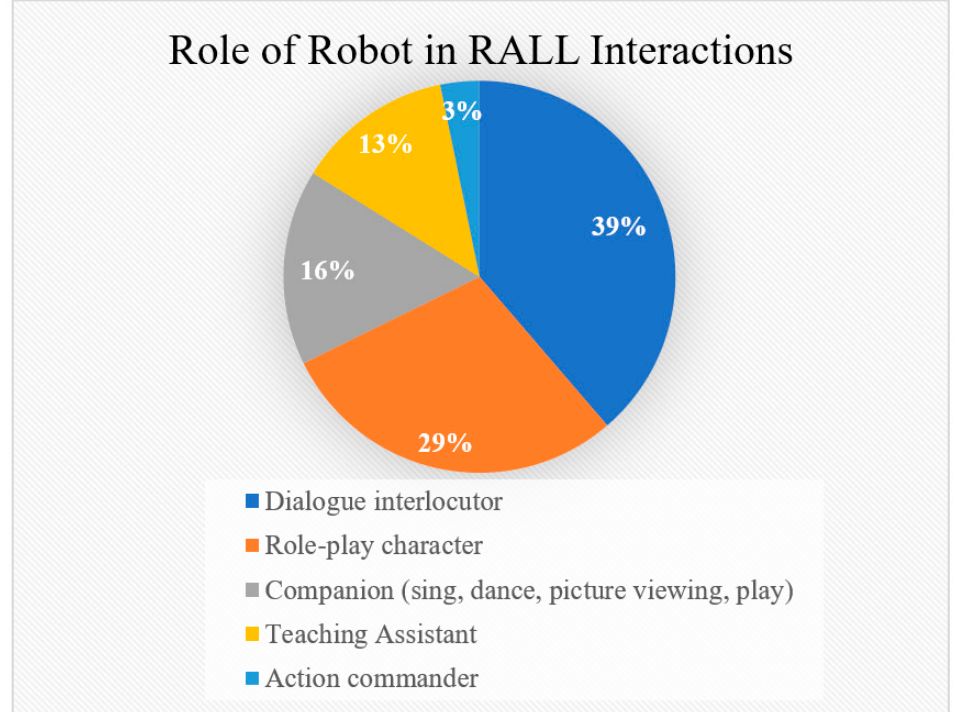
Figure 6. Roles played by robots in oral interactions.